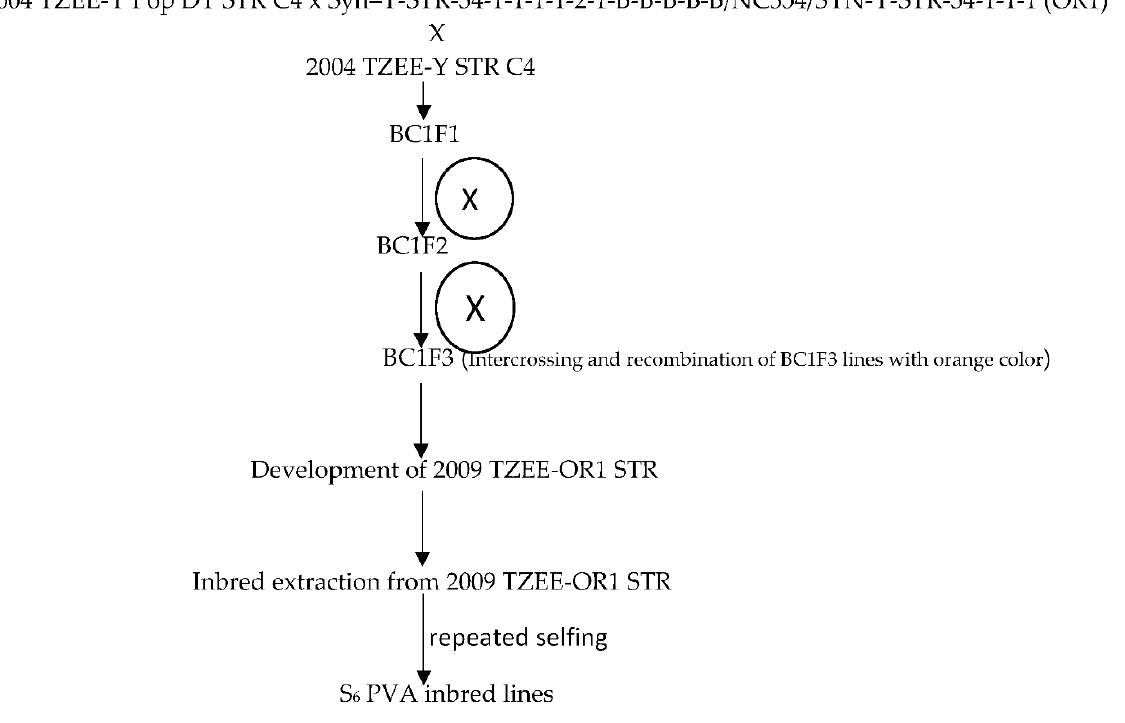
Figure 1. Extraction of the PVA inbred lines derived from the source population 2009 TZEE-OR1 STR.